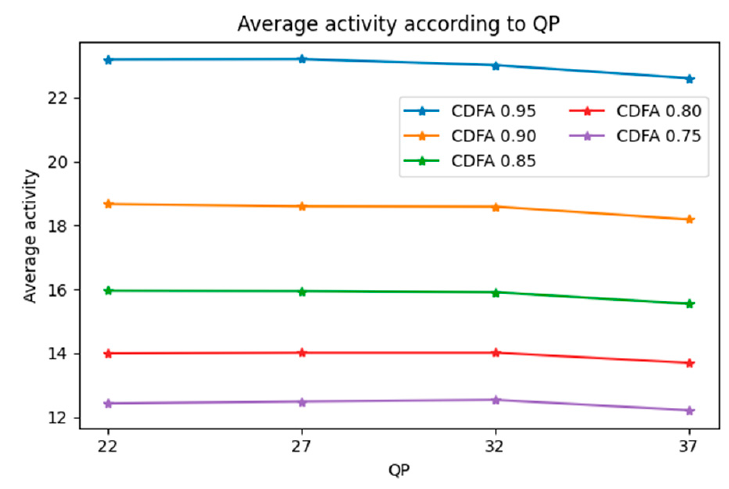
Figure 6. Changes in average activity according to QPs at fixed value of CDFA.